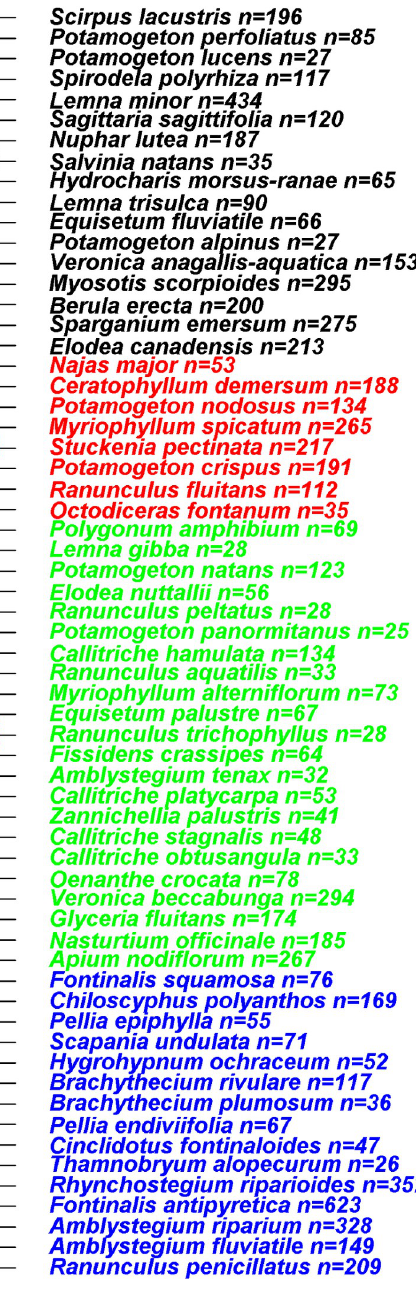
Fig 2. Dendrogram with four groups used in the RF models. n = number of species’ occurrences in the group. sites. This number was derived from initial data screening, chosen to prevent the grouping of species in non-representative clusters due to minimal sample size. This resulted in rarely occurring species being excluded from the analysis (e.g., Chara globularis with n = 3, Potamo- geton polygonifolius with n = 15, Ranunculus baudotii with n = 1 or Utricularia vulgaris with n = 3). The dataset used in our analysis covered 1,896 unique sampling sites surveyed between 1994 and 2011 including 62 species and 8,090 species records (see Fig 2).